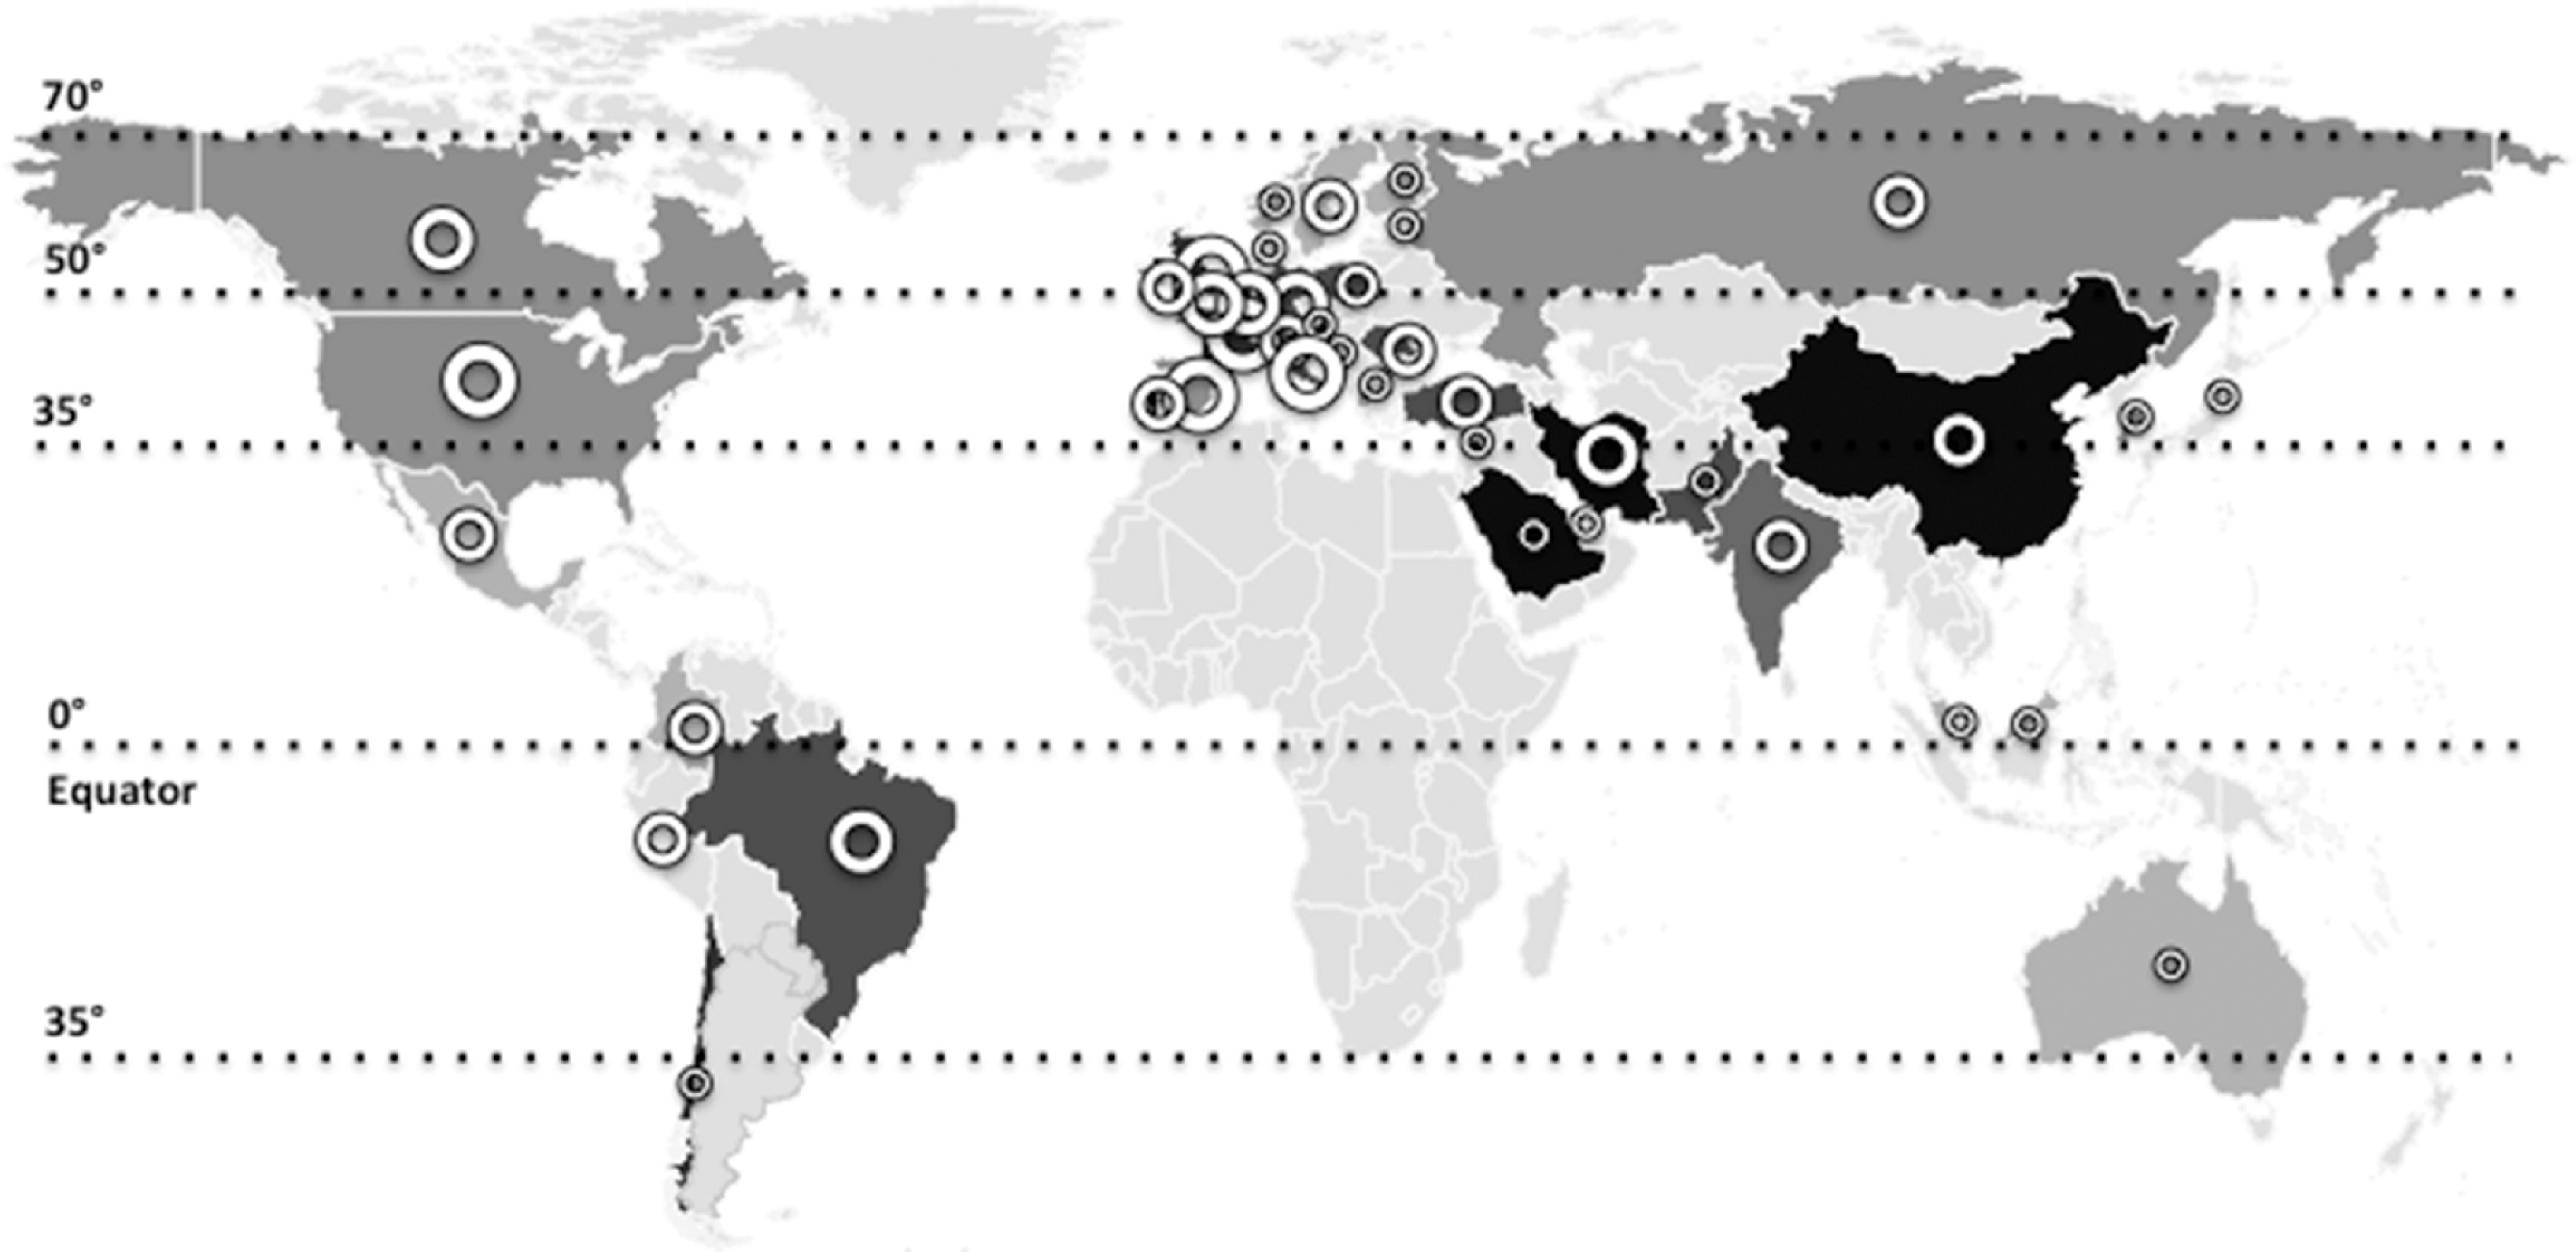
The world map illustrates the total deaths and percentage of severe vitamin D deficiency in countries most commonly affected by COVID-19(1,5–43). Severe vitamin D deficiency (%): (), >30 (South Arabia, Qatar, Iran, China); (), 20–30 (France, Chile, UK, Portugal); (), 10–20 (Austria, Pakistan, Italy, Poland, Brazil, Israel, Croatia, Romania, Turkey, Germany); (), 5–10 (India, Russia, Switzerland, Canada, Belgium, USA, South Korea, Ireland, Spain); (), <5 (Greece, Singapore, Mexico, Japan, Ecuador, Australia, Sweden, Malaysia, Norway, Finland, Denmark, Netherlands). Total deaths: (), >25 000 (USA, UK, Italy, France, Spain); (), 5000–10 000 (Brazil, Belgium, Germany, Iran, The Netherlands, Canada); (), 1000–5000 (China, Mexico, Turkey, Sweden, India, Ecuador, Russia, Peru, Switzerland, Ireland, Portugal, Romania); (), 500–1000 (Poland, Pakistan, Japan, Austria, Denmark); (), <500 (Chile, Finland, Saudi Arabia, Israel, South Korea, Norway, Greece, Malaysia, Australia, Croatia, Singapore, Qatar).